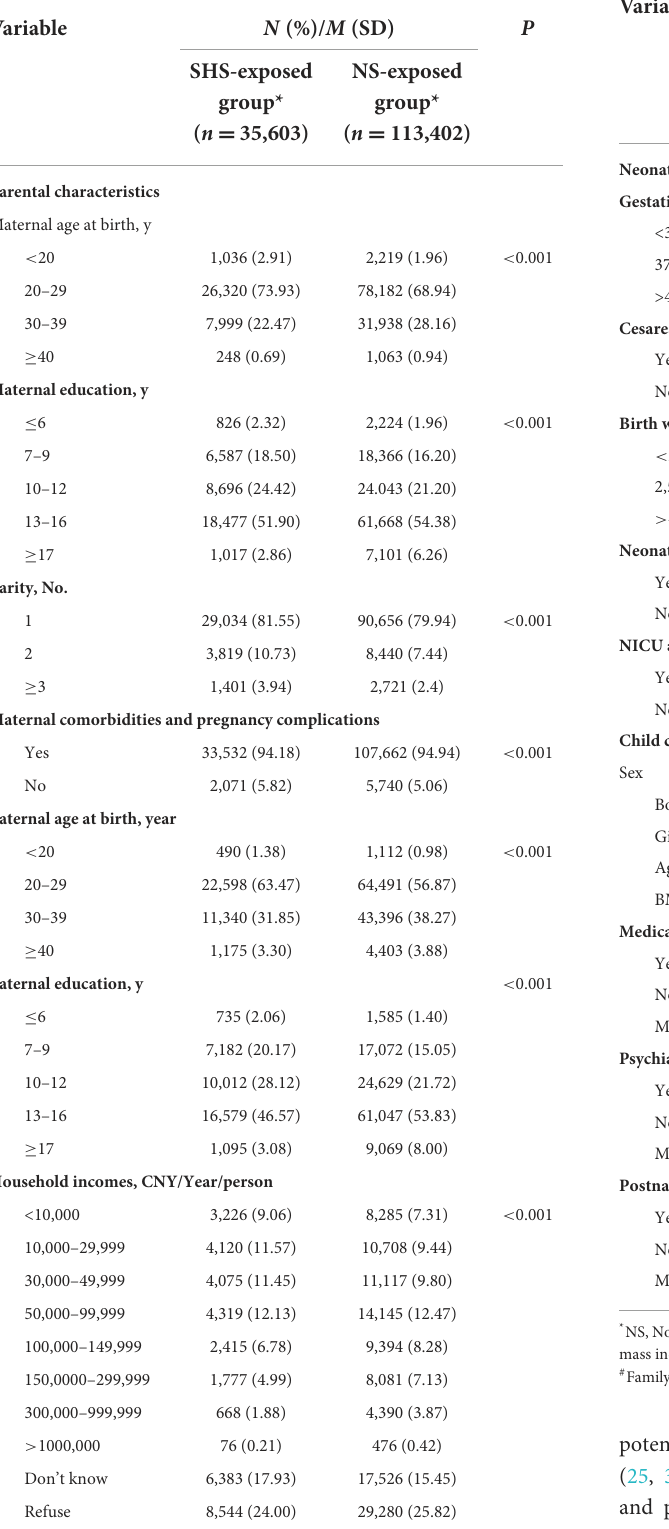
TABLE 1 Maternal, family and child characteristics of prenatal SHS-exposed and NS-exposed groups.